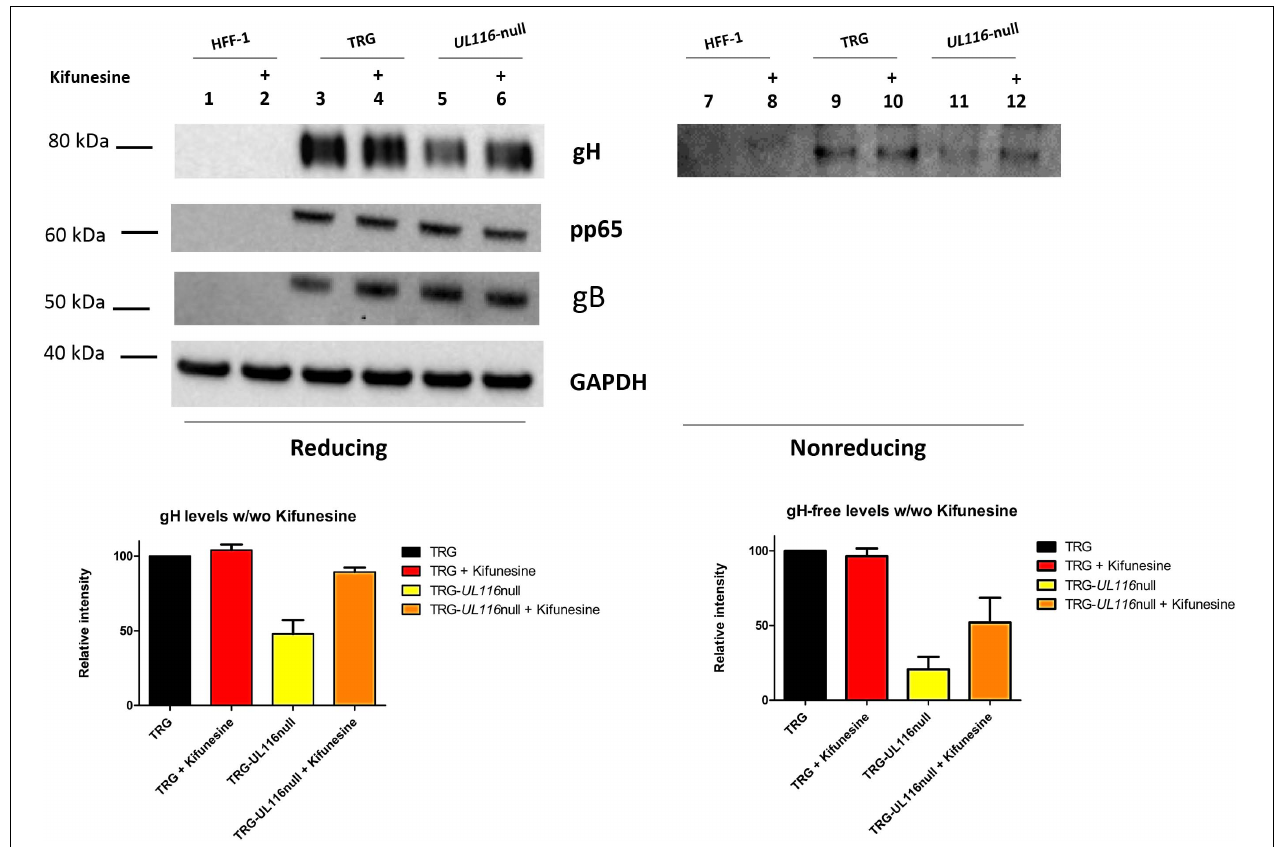
FIGURE 5 | Free-gH levels in WCL from HFF cells infected with TRG and TRG- UL116 -null under kifunensine treatment. HFF-1 cells were infected in duplicate with TRG wt and TRG- UL116 -null at an MOI of 1. After 24 h of infection, 5 µ M kifunensine was added to one of the pair cultures and incubated for additional 48 h. Cells were then harvested, lysed and WCLs were treated for western blot analysis under both reducing (lanes 1–6) and non-reducing conditions (lanes 7–12). Non infected cells were treated identically and used as control (lanes 1, 2 and 7, 8). Protein separation was achieved on 4–12% NuSieve gels (Invitrogen) using equal amount of total protein (BCA). Samples treated with Kifunensine (lanes 2, 4, 6, 8, 10, and 12) are indicate with a + on the top of the lane. Rabbit polyclonal anti-Pentamer was used to detect gH. Intensity of the GAPDH bands was used to normalize values reported on the graph. Data are reported as mean of five independent experiments with statistical